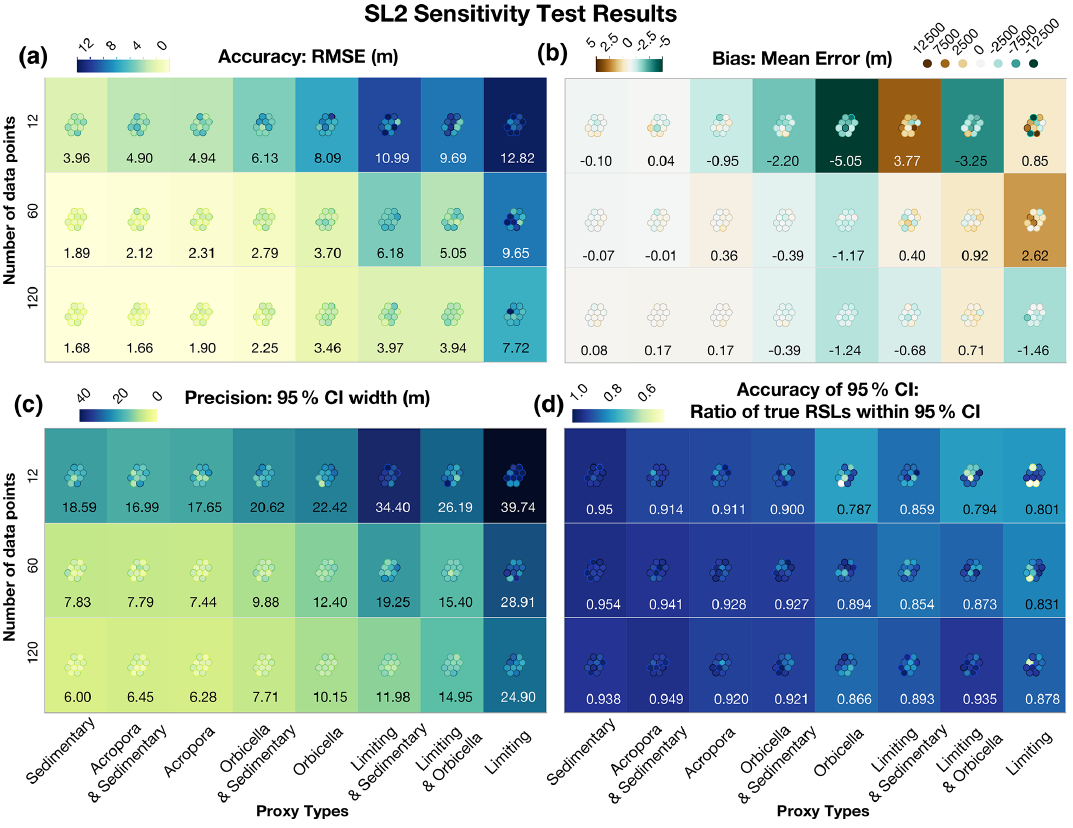
Figure 10. SL2 sensitivity test results. The quantity of data is shown on the left, and the type of proxy is displayed on the bottom of each panel. The numbers in the boxes represent the cross-model averages of each metric, and the circles represent each of the individual tests. The specific values of these individual metrics are shown in Table D6. (a) Accuracy is represented by the root-mean-square error (RMSE), where blue values indicate less accuracy; (b) bias is represented by the mean error, where green is negative bias and brown is positive bias; (c) precision is measured by the width of the 95% credible interval (CI), where blue signifies the least precise model runs; and (d) accuracy of the uncertainty intervals is measured by the ratio of true values within the 95%CI or coverage percentage, where blue represents the highest coverage or greatest accuracy (Table